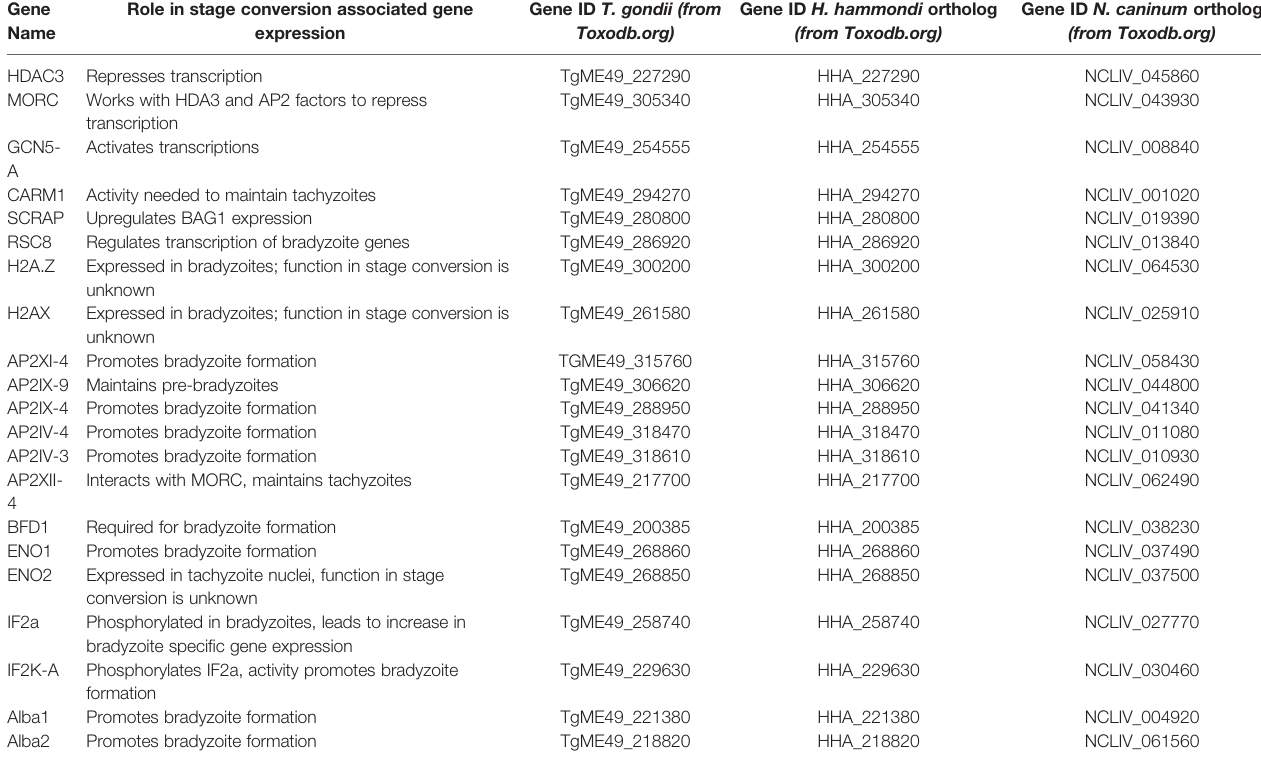
TABLE 2 | Summary of genes known to play a role in stage conversion in T. gondii